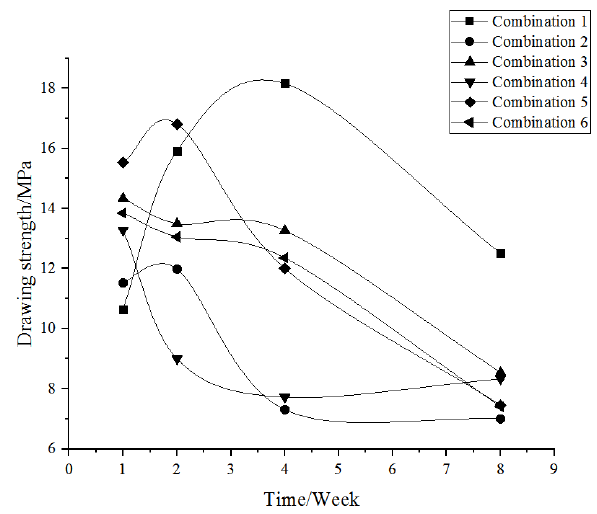
Figure 9. Room temperature salt bath pulling strength.